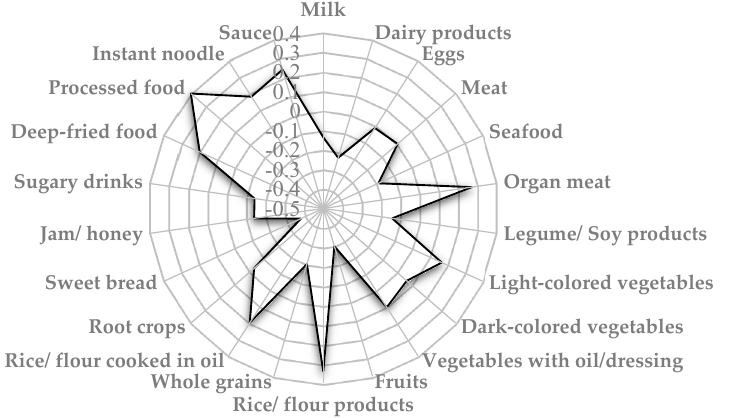
Figure 3. Spider-web diagram of factor loadings for cardiovascular risk dietary pattern.